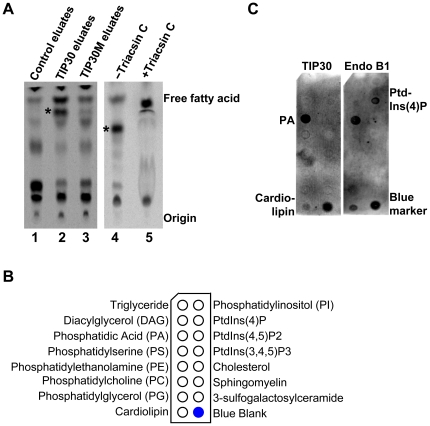
TIP30 and Endo B1 strongly bind phosphatidic acid.(A) Fatty acylation of endosomal lipids by the TIP30 complex. [3H]-arachidonic acid can be transferred to endosomal membrane lipids by the TIP30 complex, but not by TIP30M immunoprecipitates or control immunoprecipitates (left panel). The transfer was blocked by 10 µM triacsin C (right panel). Image was acquired by scanning lipids resolved on TLC plate with a Molecular Dynamics Storm 860. * indicates the radiolabeled lipid. (B) The schematic diagram shows the lipid species pre-spotted on membranes that are used in lipid-protein overlay assays. (C) TIP30 and Endo B1 strongly bind phosphatidic acid (PA). Protein-lipid overlay assays were carried out by incubating recombinant proteins with membrane strips containing 15 pre-spotted lipids. Membranes were scanned using a Li-Cor scanner after being sequentially overlaid with primary and fluorescent secondary antibodies.